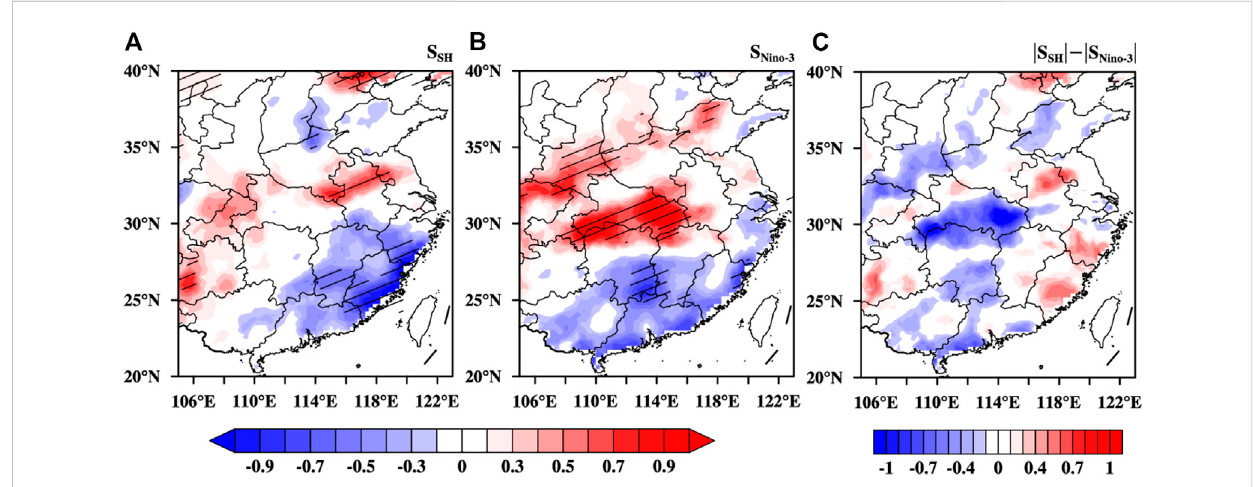
Contributions of (A) SH ( A ), (B) ENSO ( B ), and (C) difference ( |A| - |B| ) for the midsummer precipitation in South China. The areas shaded with diagonal lines in (A) and (B) pass the 90% signi fi cance test.